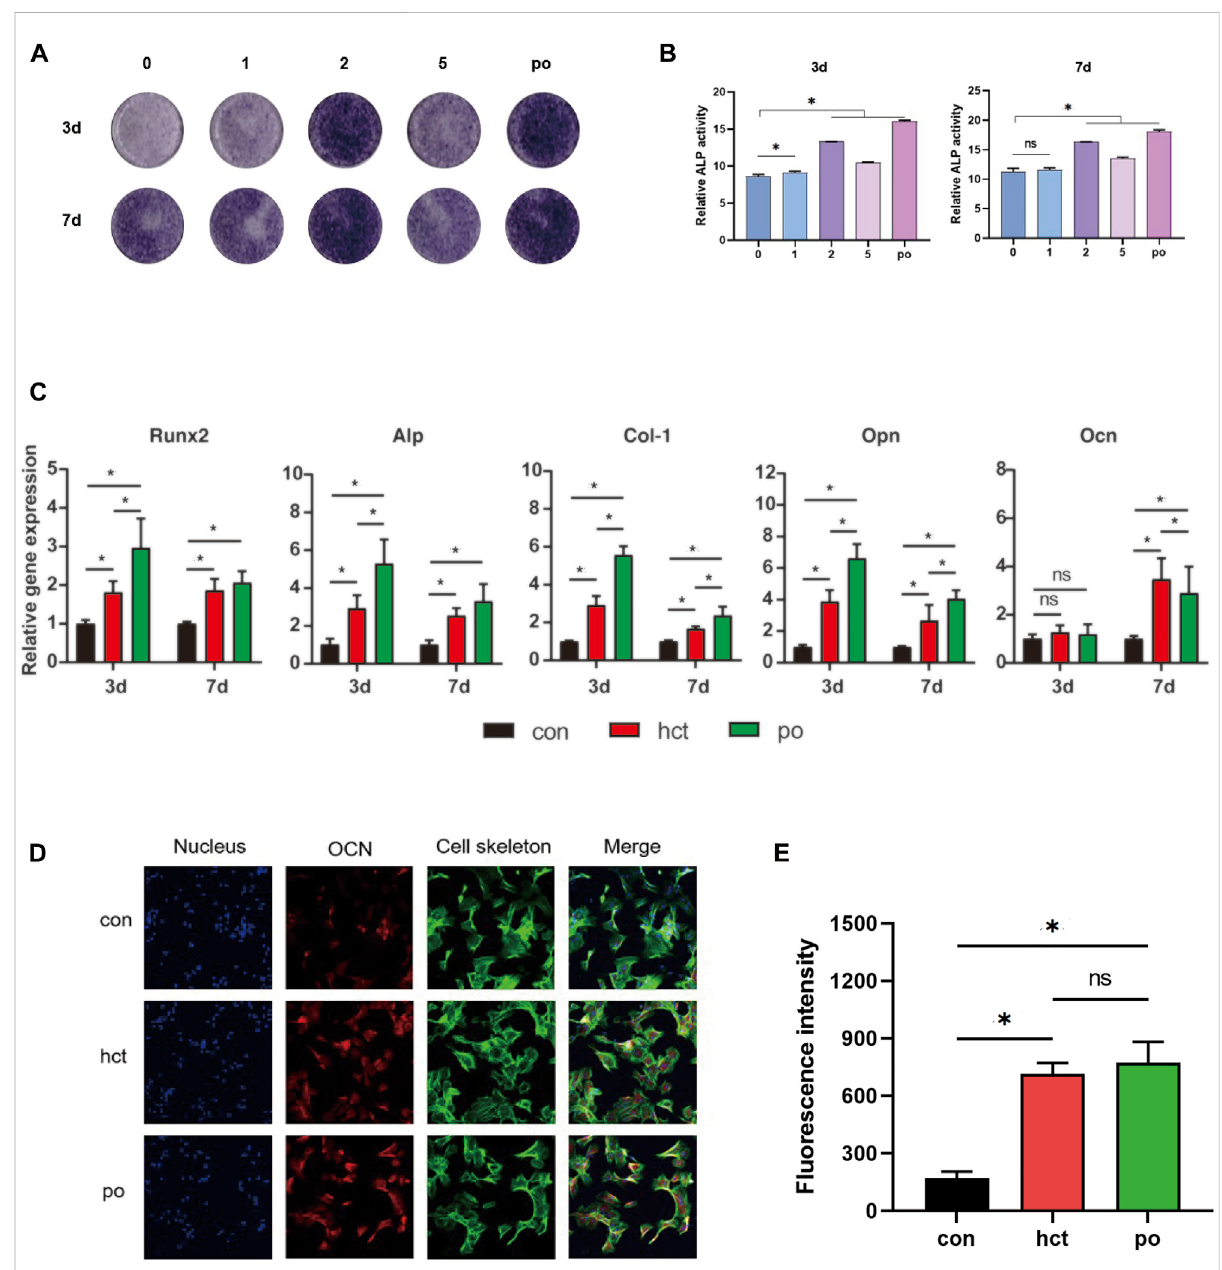
FIGURE 2 Osteogenic effect of hydroxycholesterol. (A,B) ALP staining (A) and ALP quantitative activity assay (B) of BMSCs administered with different concentrations of hydroxycholesterol and BMP-2 as the positive group (po in short) at days 3 and 7. (C) Expression of osteogenesis-related genes